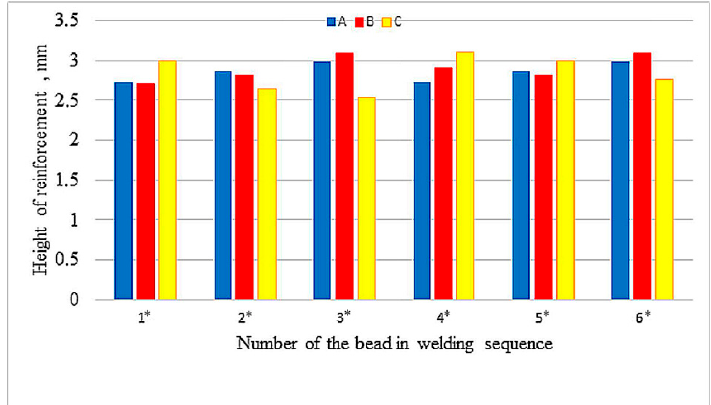
Figure 5. Heat-Affected Zone (HAZ) depth of particular beads.